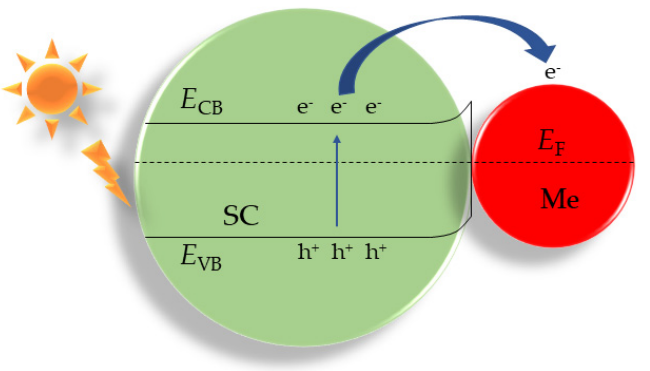
Figure 3. Band structure of the Schottky barrier between metal nanoparticles and a semiconductor: E F is the Fermi level; SC is the semiconductor; Me are metal nanoparticles.